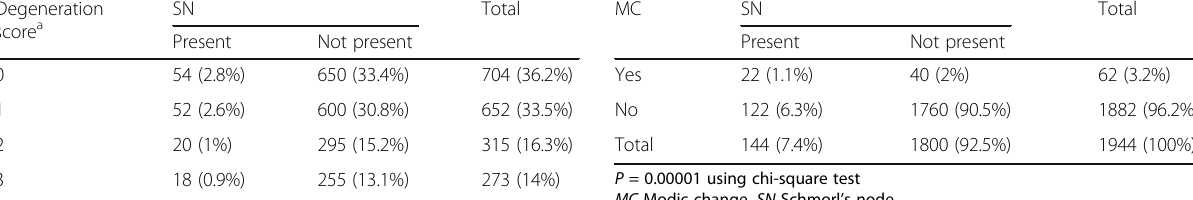
Table 4 The degeneration scores of SN-affected levels Degeneration score a